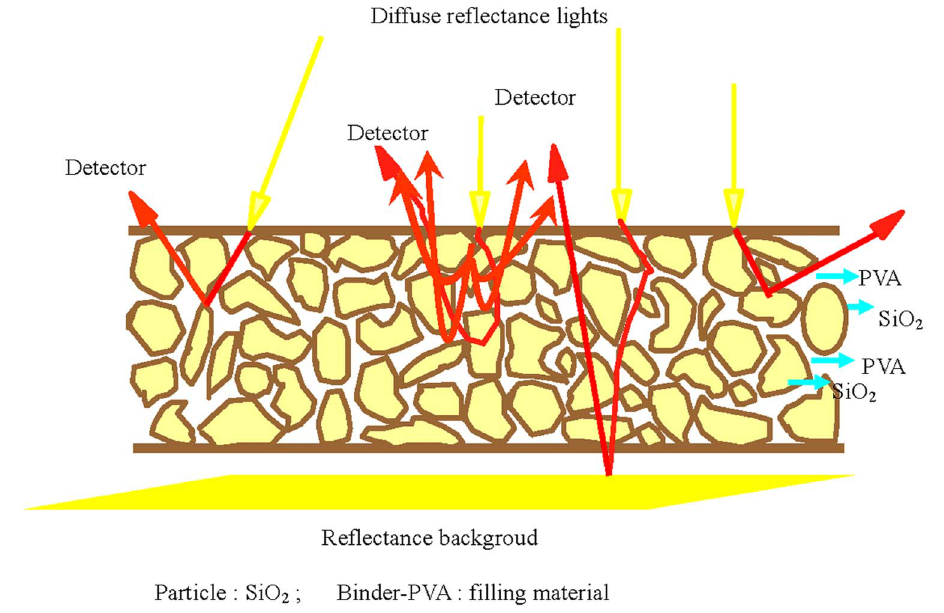
Figure 3. Mode of action NIR diffuse reflectance light on RC-IJP.